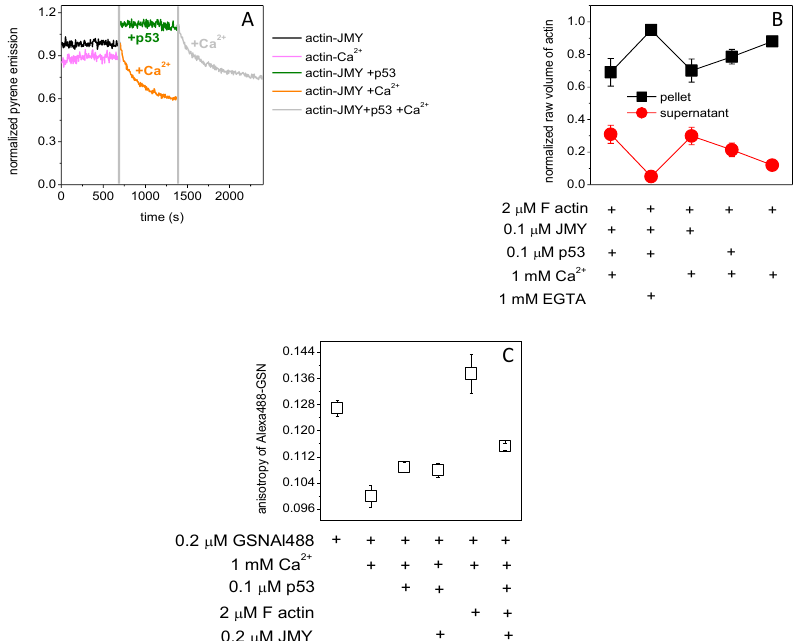
(Figure 2B) with p53 (0.1 μM) and/or JMY (0.1 μM) (by SDS -PAGE Figure S1A) shows a remarkable loss of filamentous actin: 30%. It reduced the pellet size in favor of superna- tant in the presence of 1 mM Ca 2+ and JMY, suggesting that JMY was sequestering monomeric actin in the presence of millimolar Ca 2+ . The p53 binding caused by minor release (20%) of actin monomers is not yet understood, but the p53 binds directly to fil- presence of Ca 2+ . Interestingly, with normalized fluorescence emission change of 0.5 µ M, amentous actin (Kd is 10 μM [30]) in the presence of Ca 2+ . Interestingly, with normalized p53Alexa488 shows high affinity to the GSN (Kd= 0.207 ± 0.15 µ M) (Figure S1B), similarly fluorescence emission change of 0.5 μM , p53Alexa488 shows high affinity to the GSN to p53 dimers in the presence of Ca 2+ (Kd= 0.257 ± 0.067 µ M) (Figure S1C). The p53 can (Kd= 0.207 ± 0.15 μM) (Figure S1B), similarly to p53 dimers in the presence of Ca 2+ (Kd= 0.257 ± 0.067 μM) (Figure S1C). The p53 can bind to JMY in the presence (Kd= 0.362 ± bind to JMY in the presence (Kd= 0.362 ± 0.081 µ M) but cannot in the absence of Ca 2+ 0.081 μM) but cannot in the absence of Ca 2+ (Figure S1D, E). The formation of actin – GSN (Figure S1D,E). The formation of actin–GSN or actin–JMY complexes might be modulated by p53 binding. The effect of p53 binding on the formation of these complexes can be on the formation of these complexes can be measured by the fluorescence anisotropy measured by the fluorescence anisotropy change of Alexa488-labeled GSN. The steady- change of Alexa488-labeled GSN. The steady-state anisotropy change of GSN – Al488 in- state anisotropy change of GSN–Al488 indicates thermal rotational motion, and reveals dicates thermal rotational motion, and reveals Ca 2+ -caused structural changes and p53 Ca 2+ -caused structural changes and p53 binding, or by the severing and capping activity of binding, or by the severing and capping activity of GSN on short actin filaments (under GSN on short actin filaments (under polymerizing conditions 100 mM KCl, 1 mM MgCl 2 ) polymerizing conditions 100 mM KCl, 1 mM MgCl 2 ) in the presence of millimolar Ca 2+ in the presence of millimolar Ca 2+ with JMY and/or p53 (Figure 2C). The anisotropy of with JMY and/or p53 (Figure 2C). The anisotropy of 0.2 μM Alexa488– GSN in the pres- 0.2 µ M Alexa488–GSN in the presence of millimolar Ca 2+ and 0.1 µ M p53 (0.109 ± 0.0014) was at the same level as after the addition of 0.2 µ M JMY (0.108 ± 0.0022). However, the subsequent addition of filamentous actin (2 µ M) increased it a bit (0.115 ± 0.0011) and shows a relatively high value in the absence of JMY and p53 (0.138 ± 0.006). It seems that the JMY and p53 can reduce the length and number of filaments, and thus, GSN can bind only short oligomers and monomers, which was manifested in a small change of anisotropy in the presence of millimolar Ca 2+ .